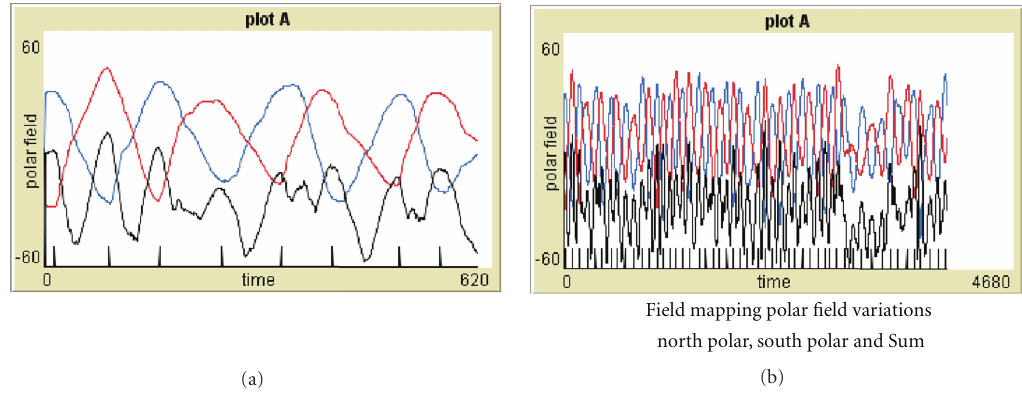
Figure 2: Displayed are two graphs of polar field variations versus time for the first 8 solar cycles (a), and for 4000 tick time units (b). Each of the graphs is of the Plot A type using the Field Mapping model 1p07 run with the Netlogo 4.1.2 code version. Shown most prominently are three colored curves: blue, red, and black. The blue curve displays the amount and sign of the magnetic flux in the northern magnetic pole, namely, the mean field above 60 degrees latitude. The red curve similarly counts the mean field in the Southern polar region. The two polar fields anti-correlate. The black curve marks the Absolute Value Sum of the red and blue curves, so it corresponds to the mean polar flux. It has been displaced downward, so the − 60 value corresponds with 0 flux, for increased clarity. The black curve essentially reaches a peak, during a solar cycle minimum, when the polar fields reach their maximum values. Again, a fourth black curve is drawn, with little blips, and placed at the bottom of each plot showing when the actual peak in the polar field occurs. These provide a good indicator of the start of a solar cycle, so one can count solar cycles with these blips. The lower graph shows an extended period of low solar activity interspersed within typical periods of high activity. The extended periods of low activity (e.g. the one near 3000 time units) may be similar to Maunder Minima type phenomena. Examinations of the lengths between field minima, shown by the tick marks in the figure, readily display an inverse correlation with polar field magnitudes. Namely, when the fields are larger, the periods are shorter. This e ff ect was discovered by Waldmeier.